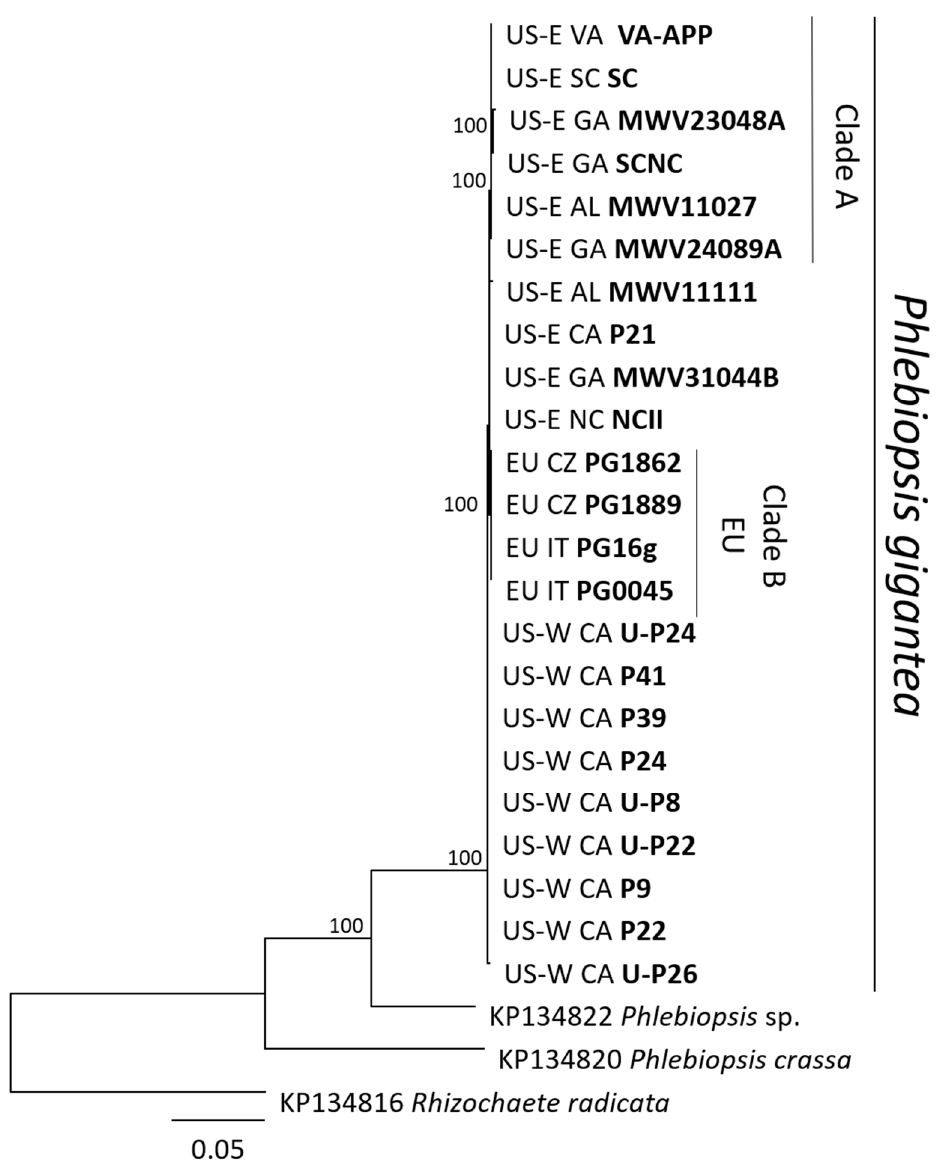
Figure 5. Maximum likelihood phylogram obtained from the RPB1 sequence alignment of Phlebiopsis gigantea . Phlebiopsis sp ., Phlebiopsis crassa and Rhizochaete radicata were used as outgroup taxa. ML bootstrap percentages ≥ 70% are given above each clade. Labels indicate: geographic area, state, isolate code (in bold for sequences newly generated) and GenBank code brackets for sequences retrieved from